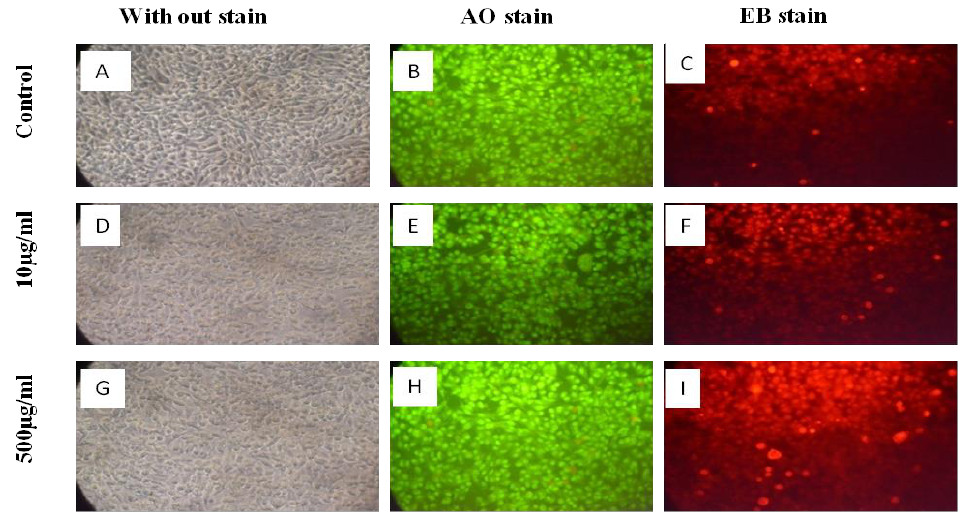
Figure 3. Morphology analyses of L929 cells treated with Solanum indicum extract.